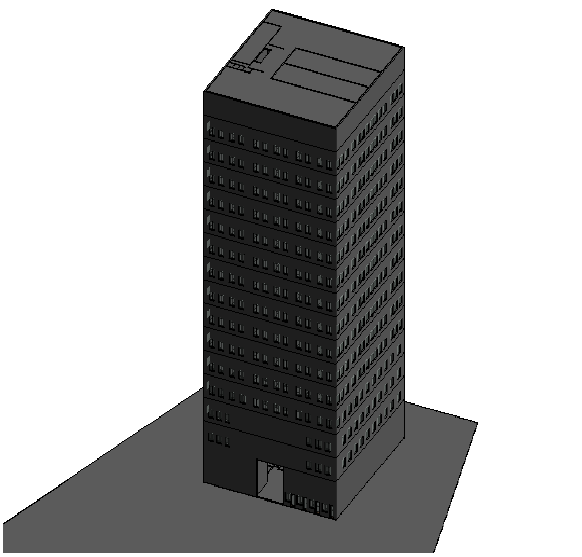
Figure 6. Plasco Building Information Model in Revit 2020